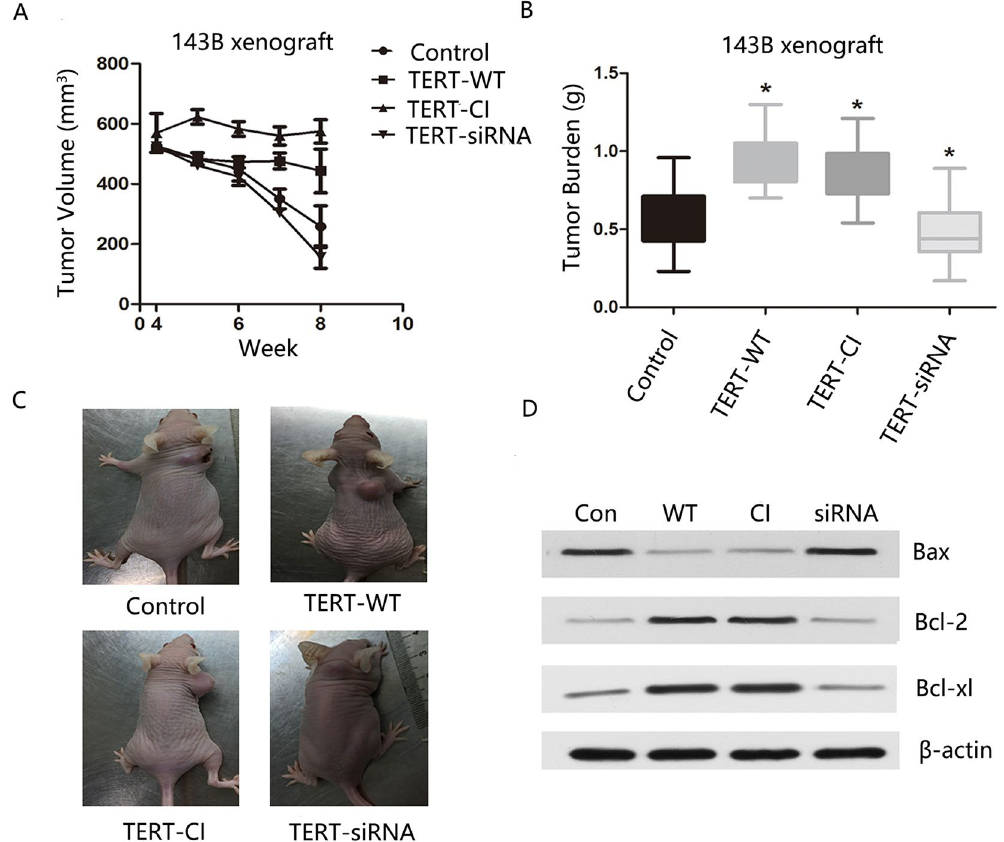
Figure 5. Cisplatin-resistance of osteosarcoma cells is promoted by TERT in vivo. ( A ) BALB/C nude mice with transfected xenograft tumors of 500 mm 3 were given 5 mg/kg of cisplatin at embedded intervals of 4 days for 4 weeks. TERT-overexpressing xenograft tumors showed more resistant to cisplatin treatment. Data are represented as mean ± SEM * p < 0.05. ( B , C ) Tumor burden were assessed at time of death (8 weeks). Results expressed as mean ± 95% confidence intervals. n = 6 * p < 0.05. ( D ) Proteins were extracted from tumor burden. Apoptotic-related proteins expression were then assessed by Western blot analysis. β -actin was used as a leading control.